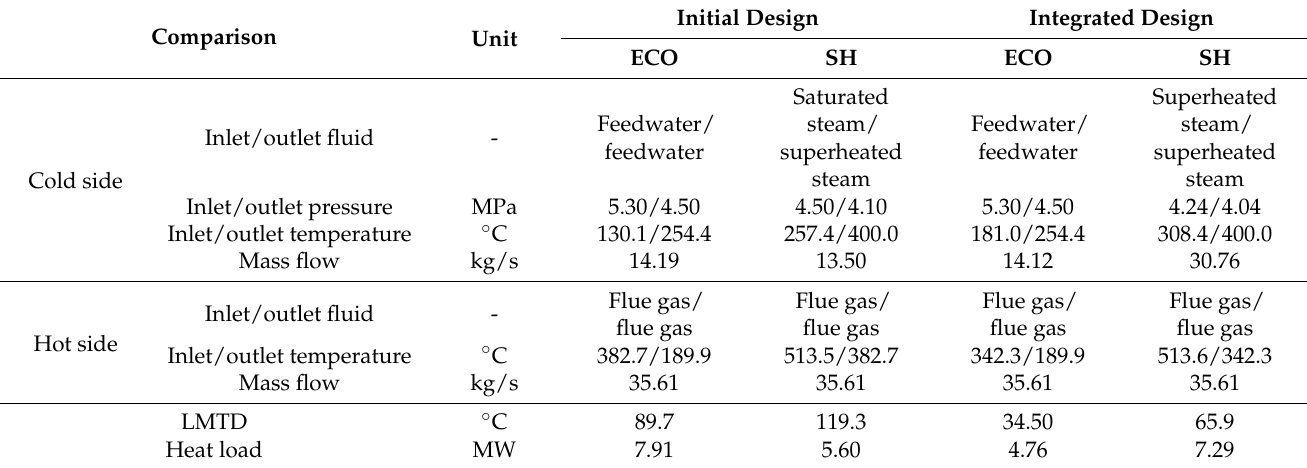
Table 12. Comparison of the ECO and SH between the initial and integrated designs.